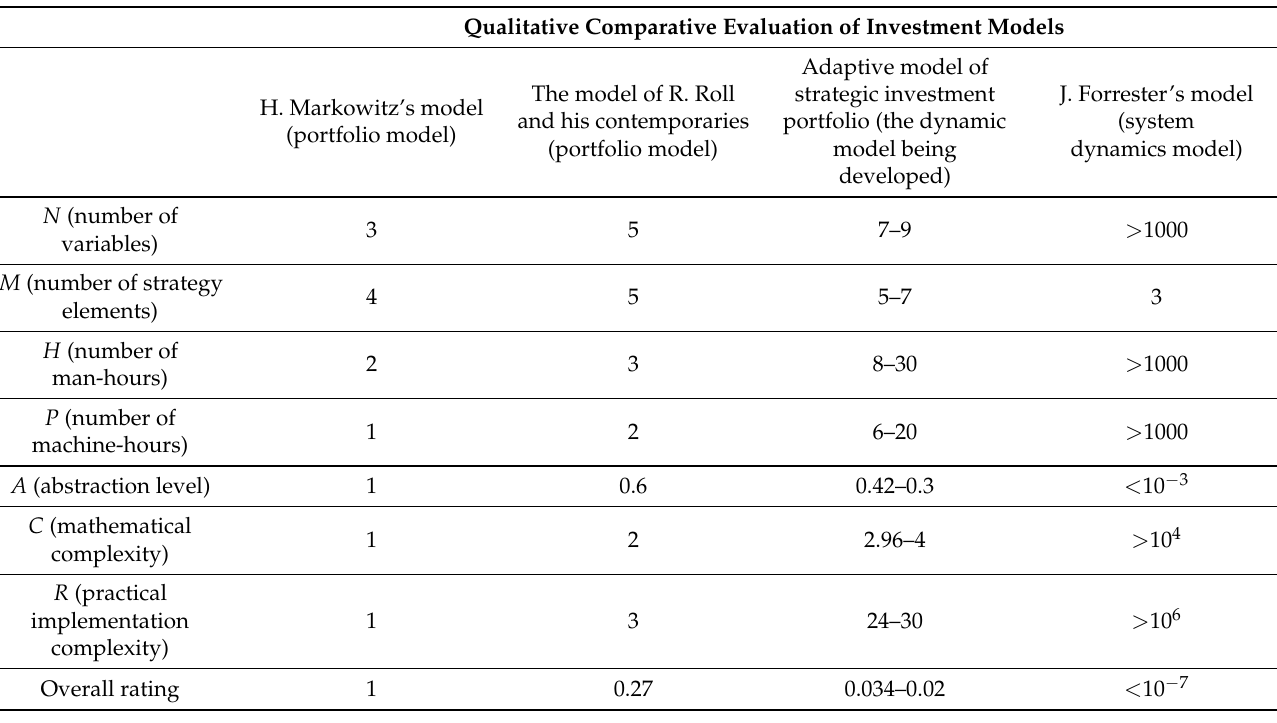
Table 6. Evaluation criteria of investment portfolio models and objective assessment of model usability. Qualitative Comparative Evaluation of Investment Models